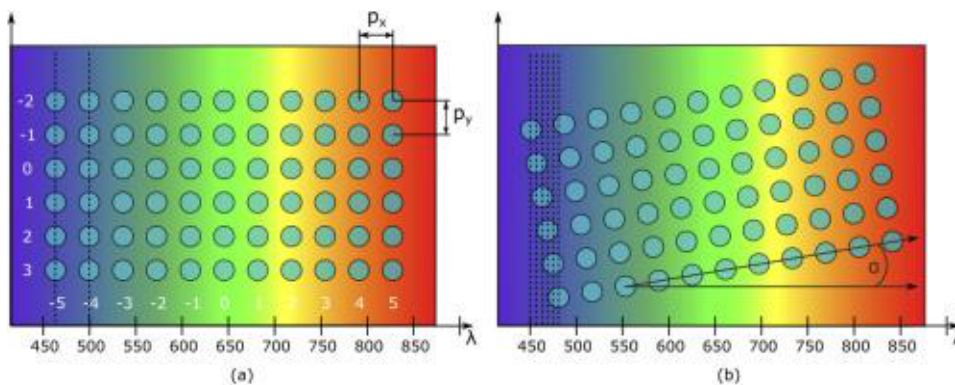
Figure 32. Position relationship between LVF and MLA. (( a , b ) are the cases without and with included angles, respectively).